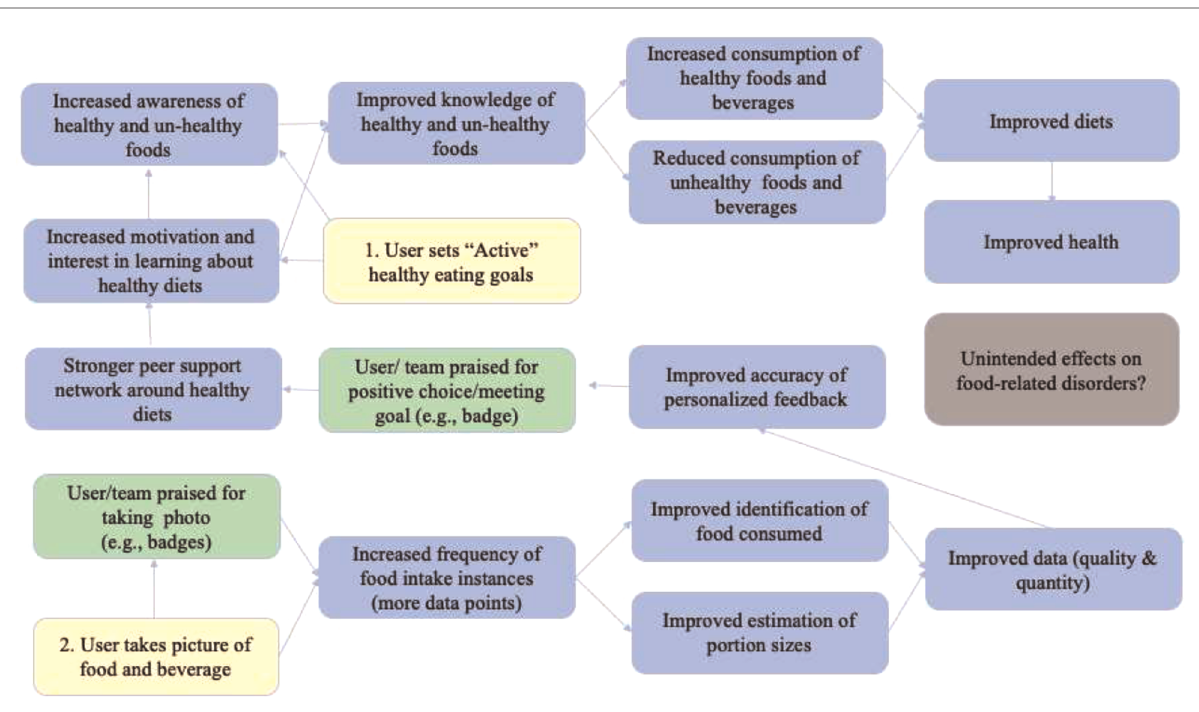
FIGURE 2 The stylized program impact pathways for the FRANI. (Source: Adapted from (21)) Notes: Yellow represents the two steps users have to follow to have their dietary consumption tracked and to be nudged to make healthier food choices. Green boxes show nudges to in fl uence the use of the FRANI and healthy food choices. Blue boxes represent what is expected to improve with the FRANI use. Gray is for a possible unintended consequence of the FRANI use that should be fi xed in future versions of the app.